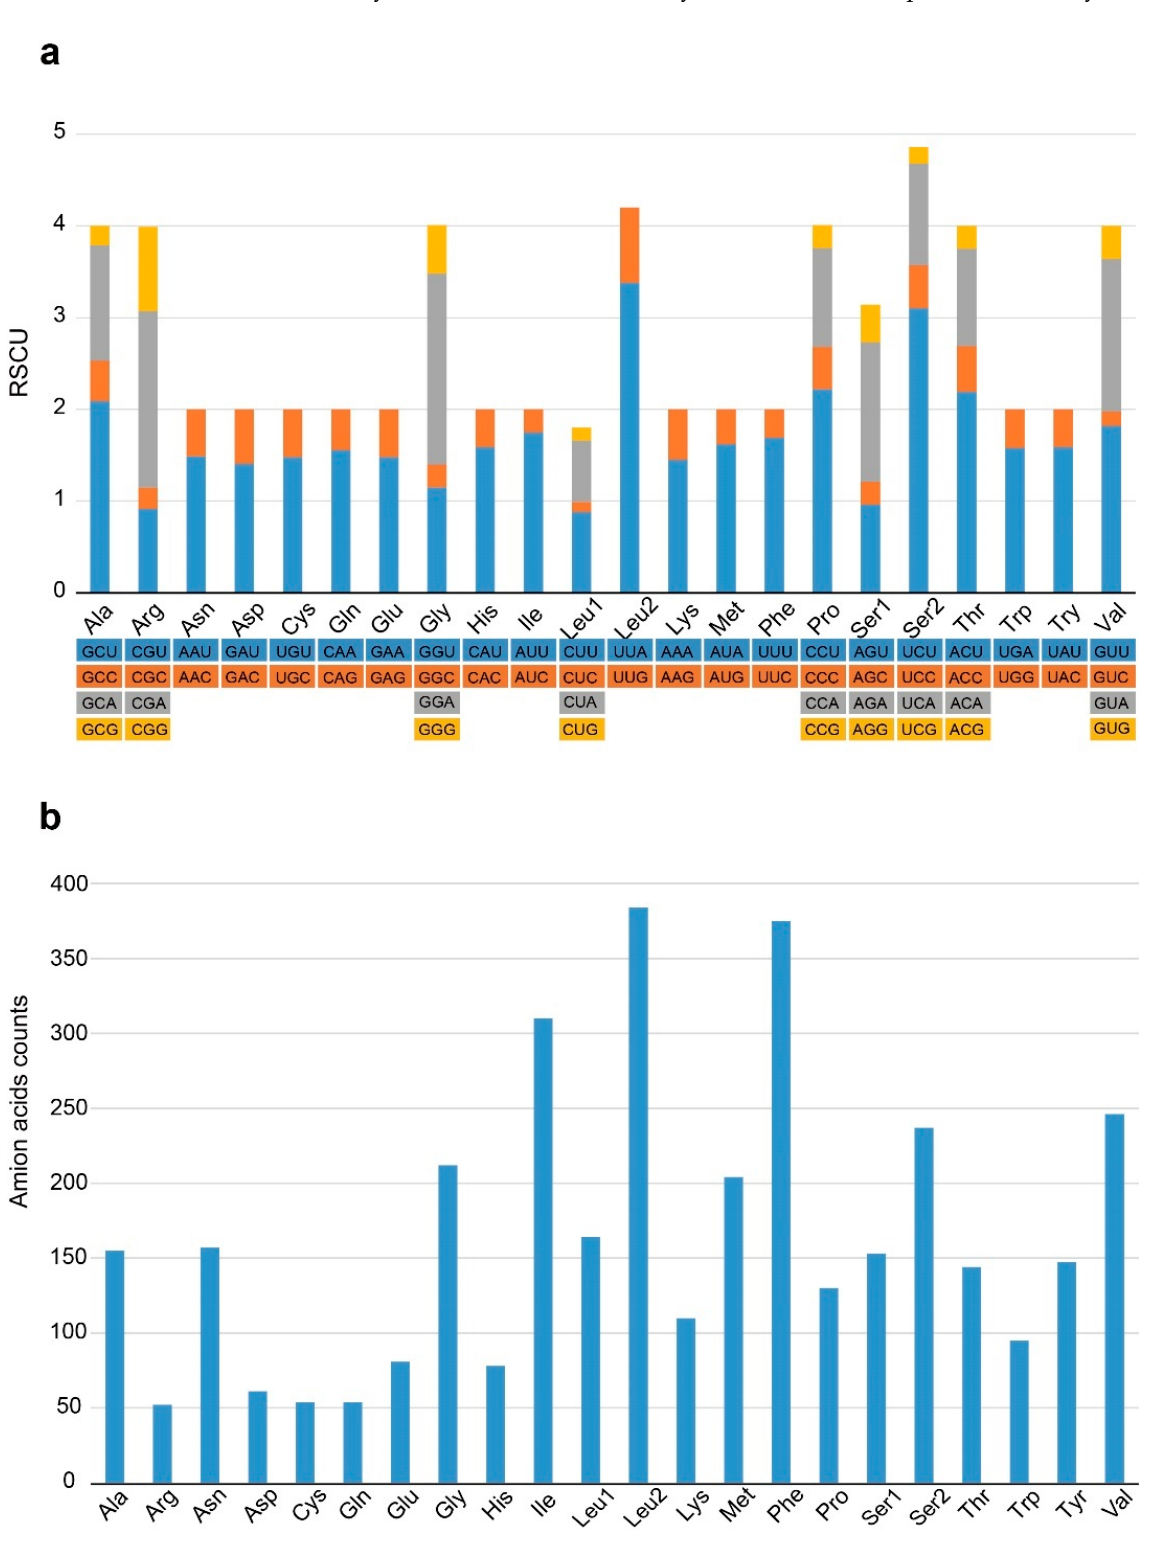
Figure 2. Distribution of ( a ) relative synonymous codon usage (RSCU) and ( b ) amino acids frequency in P. vernedei mitogenome.